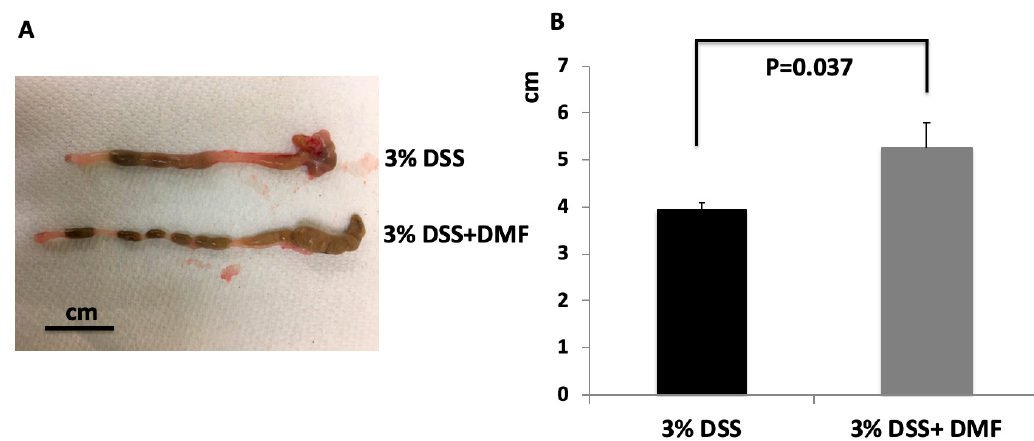
Figure 3. ( A ) Photograph of representative colon at day 7 of DSS administration. ( B ) Length of colons from mice given 3% dextran sulfate sodium (DSS) and 3% DSS+ dimethyl fumarate (DMF) (25 mg/kg twice daily). Data represent the mean ± SEM.